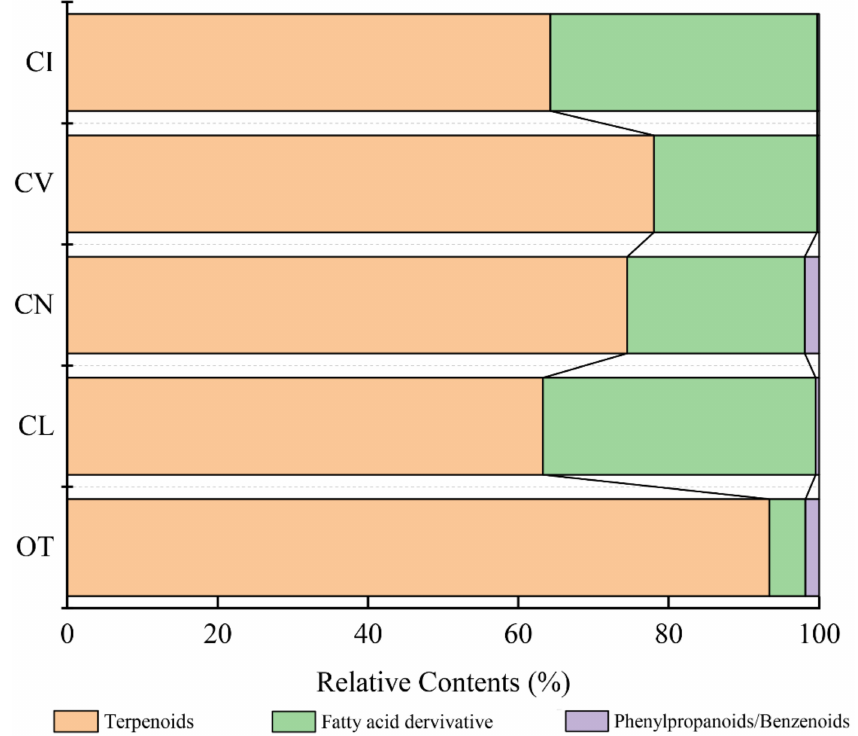
Figure 1. Comparison of the relative contents of the three major classes of scent compounds in the five species. Note: The names of the five materials in all figures and tables were replaced by